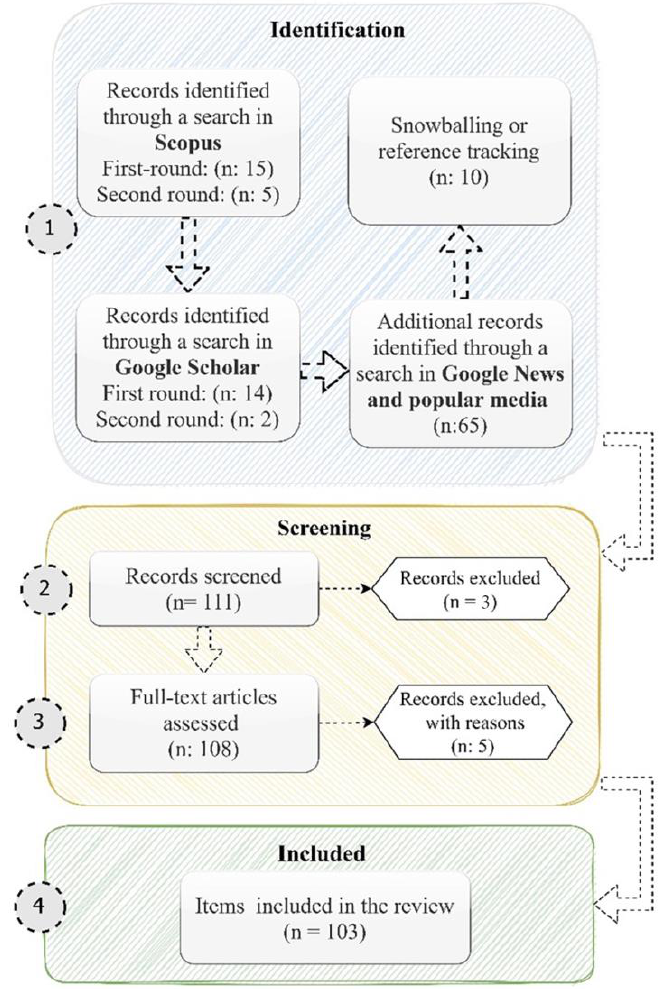
Figure 1. Literature search and selection process.